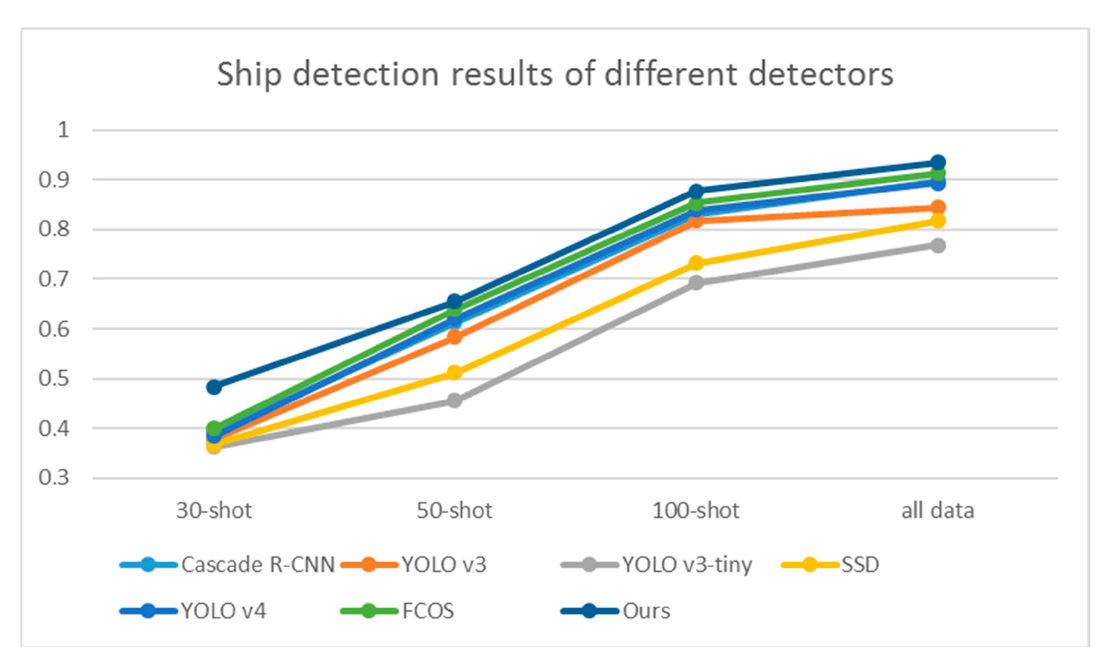
Figure 10. Ship detection results of different detectors and number of input samples.